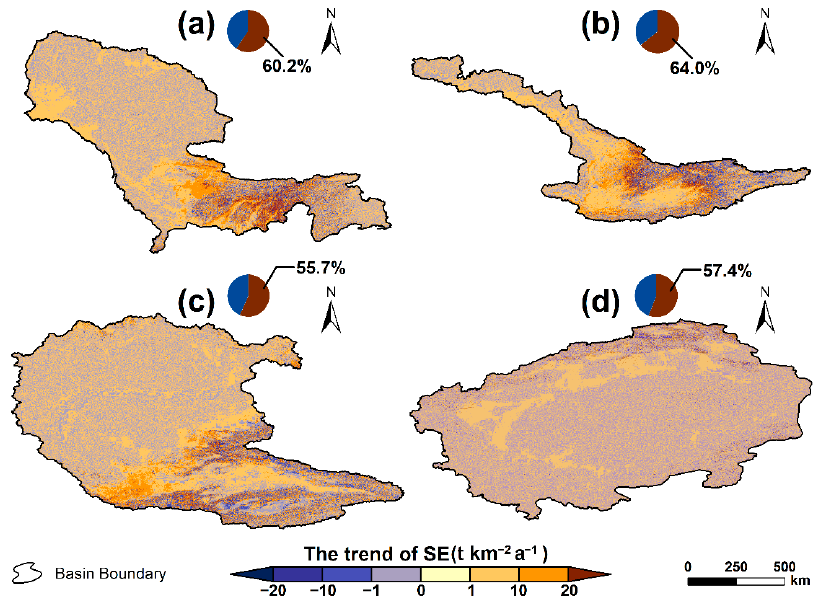
Figure 5. Spatial variation in annual SE of major basins in CA from 1982 to 2017. The pie chart shows the percentages of areas of SE increase (brown) and decrease (blue) relative to the entire basin. ( a ) ADB, Amu Darya Basin; ( b ) SDB, Syr Darya Basin; ( c ) IRB, Ili River Basin and ( d ) TRB, Tarim River